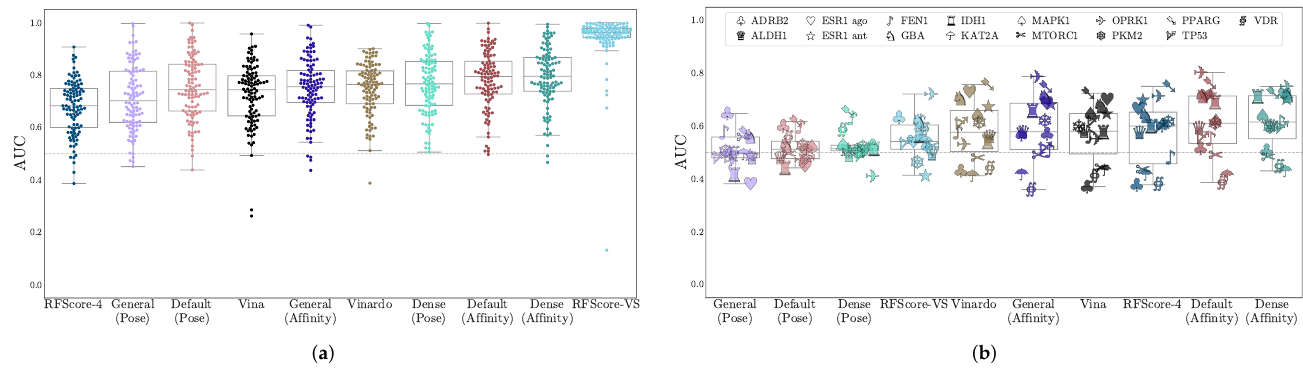
Figure 2. Assessment of virtual screening performance on ( a ) DUD-E and ( b ) LIT-PCBA using the AUC metric. The x -axis is sorted in order of increasing median performance. Each data point is the area under the curve of the ROC curve (AUC) of the method on a single target. LIT-PCBA targets are shown with distinctive individual markers.